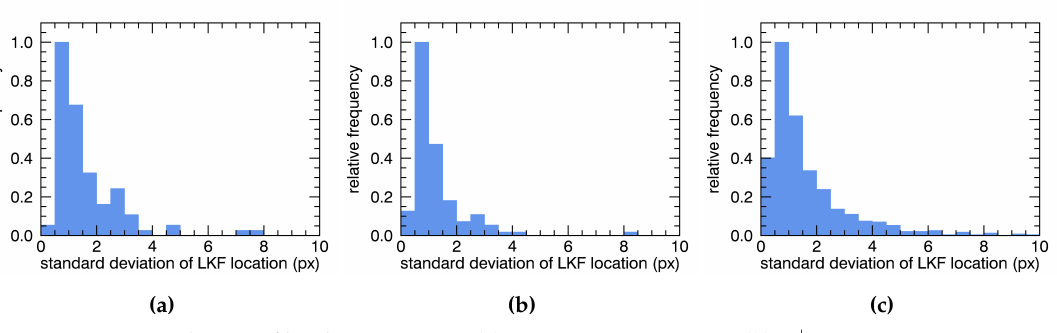
Figure 11. Distribution of localization errors. ( a ) R 0 : N=129, σ = 0.75 px; ( b ) R + ( c ) R 10 : N = 1411, σ = 0.75